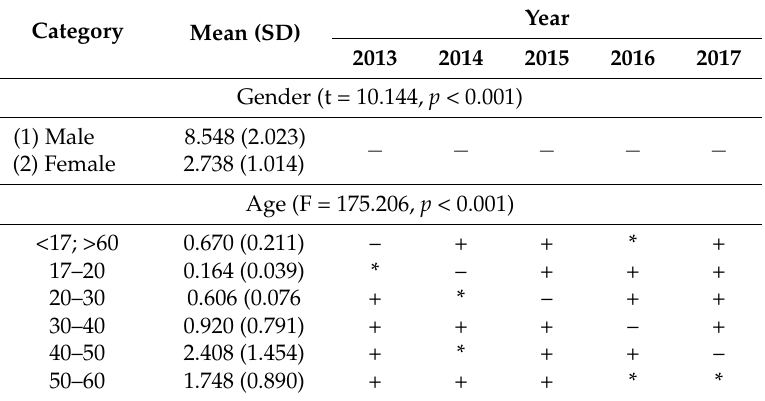
Table 7. Result of ANOVA analysis (frequency index of